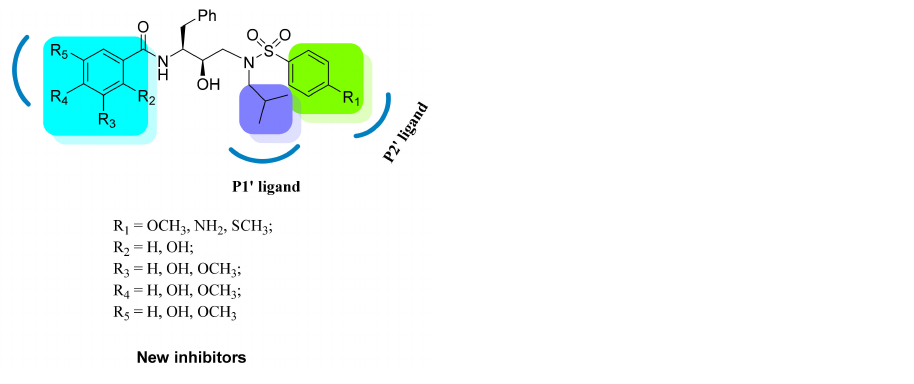
Figure 2. Structures of newly designed HIV-1 protease inhibitors. The canonical nomenclature for the inhibitor moiety position is indicated using